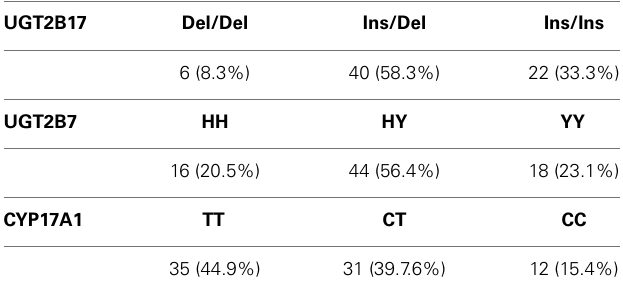
Table 2 |Allele frequencies of the three investigated polymorphisms shown as total number of athletes with the specific genotype and percentage of the whole study